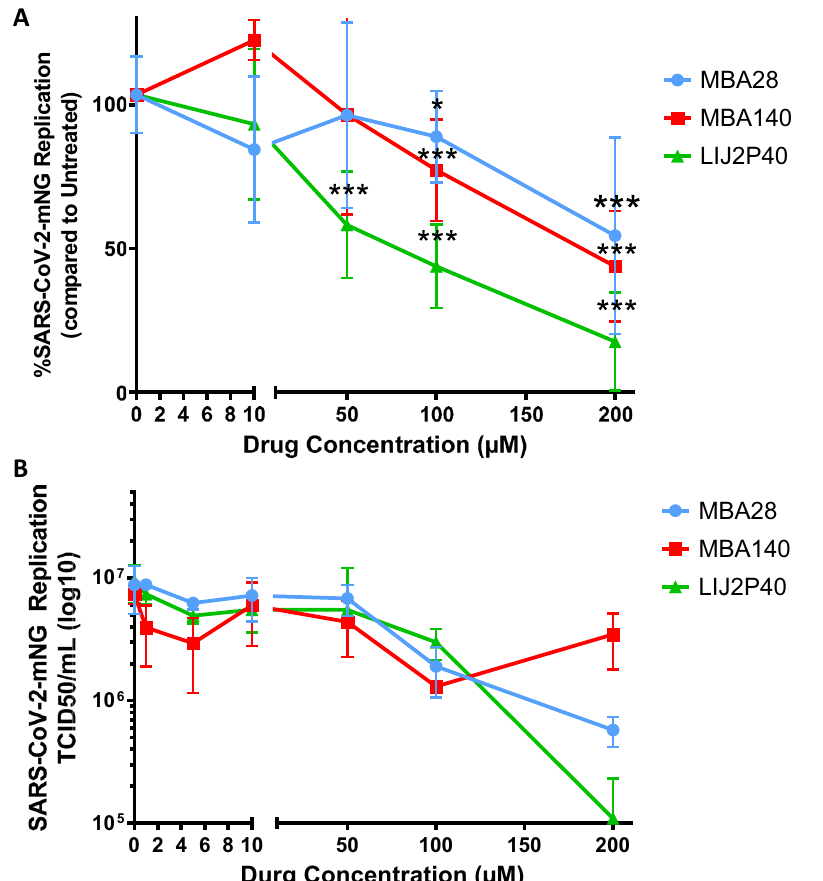
Figure 4. Inhibition of SARS-CoV-2-mNG replication in VeroE6 cells measured by RT-qPCR (A) and endpoint dilution (TCID50/mL) (B ), for LIJ2P40, MBA140 and MBA28. Cells were treated by compounds at the time of infection with SARS-CoV2-mNG (MOI = 0.01). Endpoint dilution assays and RT-qPCR were performed 48 h post-infection. Untreated cells infected with SARS-CoV2-mNG (527.10 6 copies/mL) were used for normalization of the assay. RT-qPCR results are represented as mean ± SD of three independent experiments done in triplicates. TCID50 results are represented as mean ± SD of a single experiment done in triplicates. The Wilcoxon signed-rank test (value of 100) was used as statistical test with P ≤ 0.05 = *; P ≤ 0.01 = **; P ≤ 0.001 =